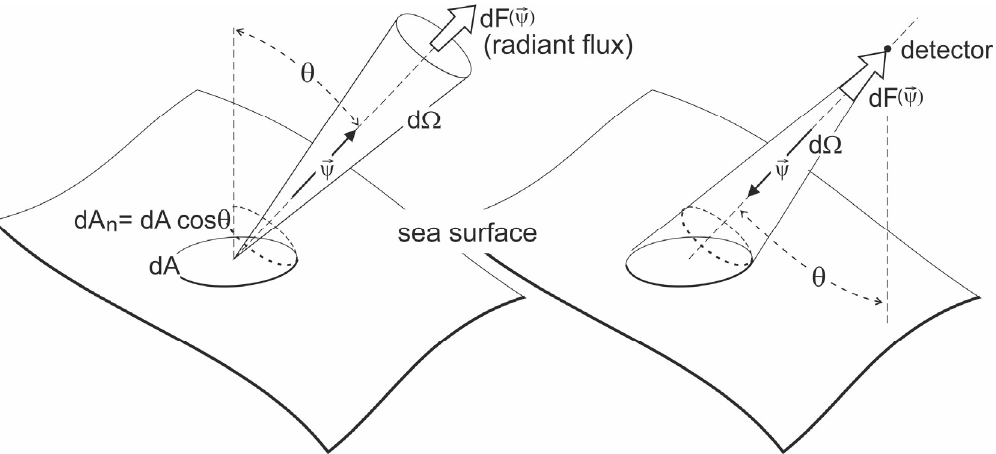
Figure 1. A geometric sketch for radiance definition (after Dera [16]).